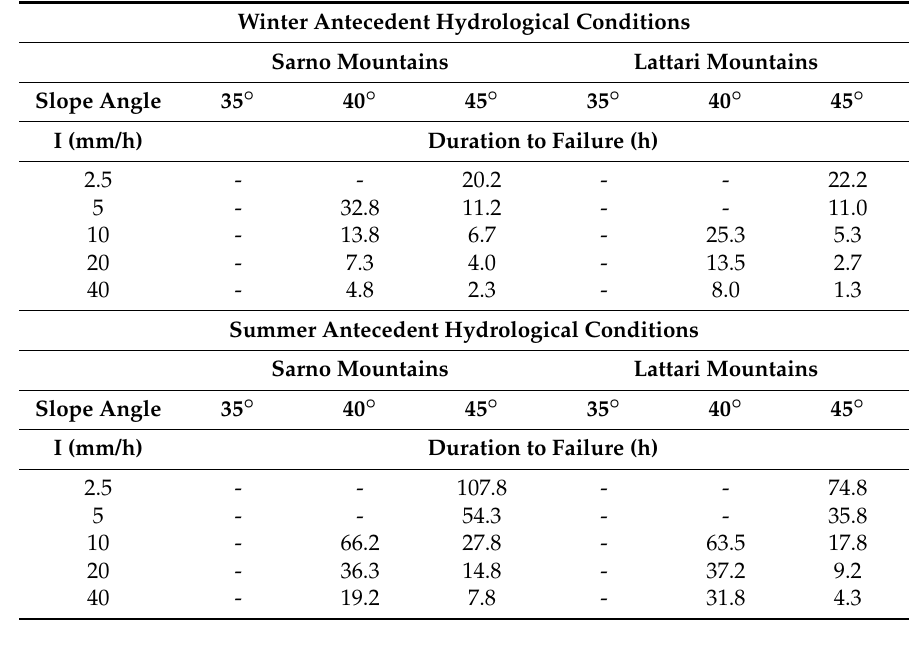
Table 5. Duration (hours) of rainfall events with constant intensity (2.5, 5, 10, 20, and 40 mm/h) to slope failure for 35 ◦ , 40 ◦ , and 45 ◦ slope models of the Sarno and Lattari Mountains related to winter and summer antecedent hydrological conditions,